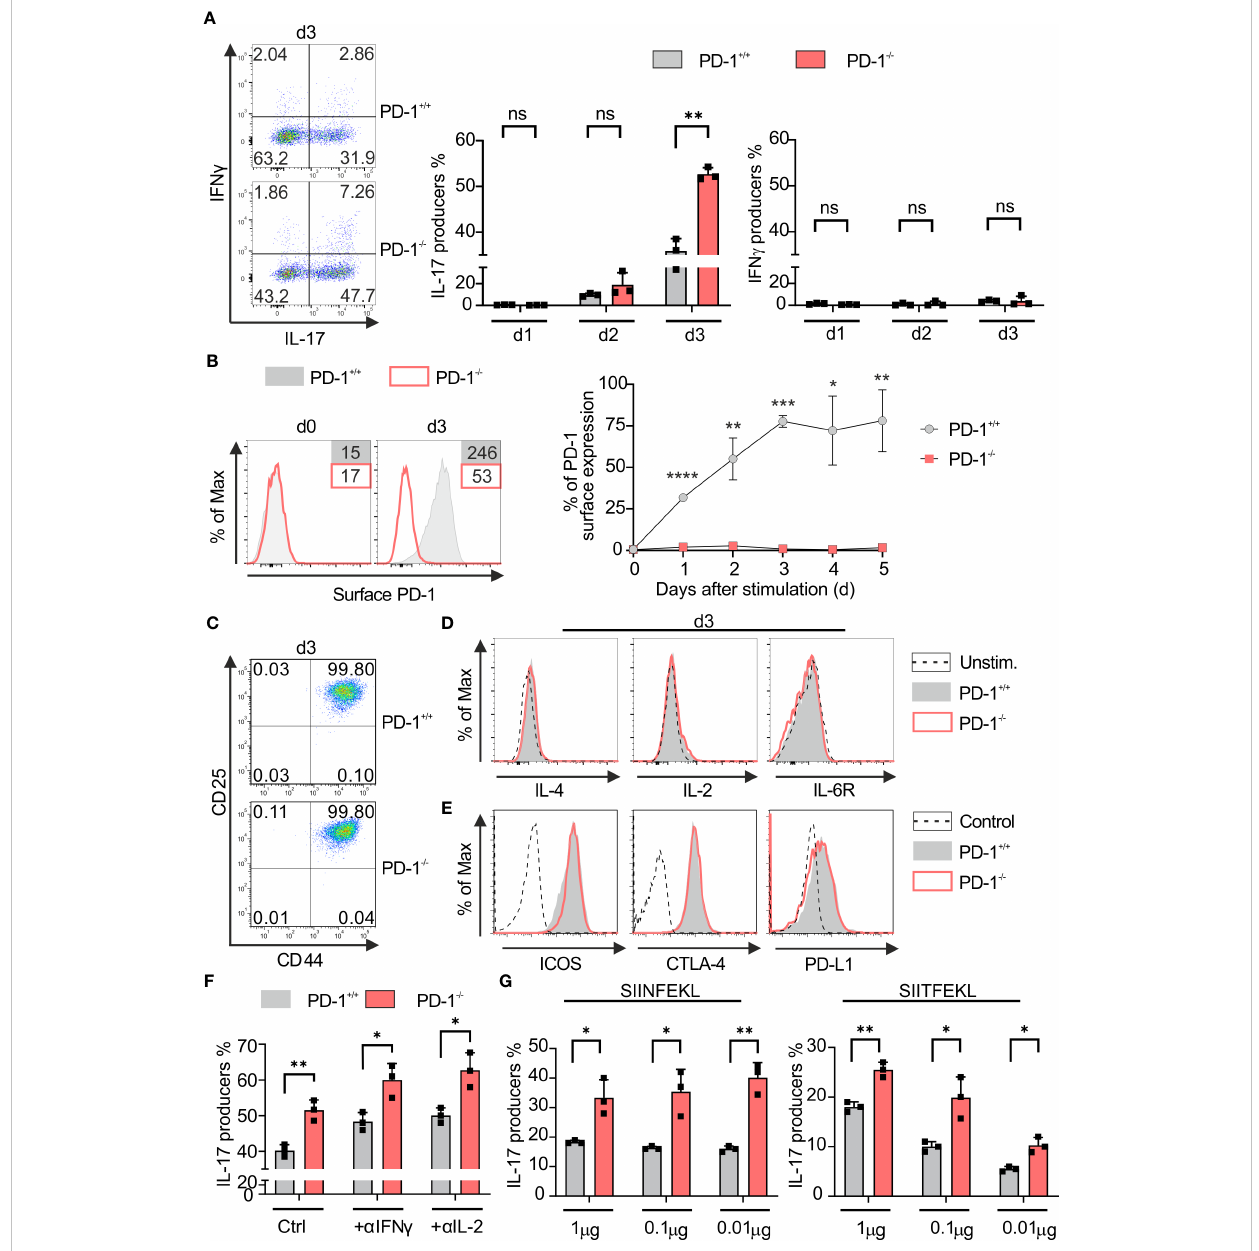
FIGURE 1 PD-1 restricts Tc17 differentiation. PD-1 +/+ and PD-1 -/- OT-1 naïve CD8 + T cells were activated antigen speci fi cally using OVA 257 – 264 loadedAPCs and cultured under Tc17 conditions. (A) Dot plot representing fl ow cytometric analysis of intracellular IL-17 and IFN- g expression (left panel) in OT-1 CD8 + T cells stimulated for 3 days under Tc17 conditions. Cumulative staining results from d1, d2 and d3 are shown on the right. (B) Histogram of PD-1 surface expression 3 days after antigen speci fi c stimulation of PD-1 +/+ Tc17 cells. PD-1 -/- Tc17 cells were used as negative controls. Graph representing kinetics of PD-1 expression on surface of PD-1 +/+ and PD-1 -/- Tc17 cells at different time points from day 0 to day 5. (C, D) Naïve PD-1 +/+ and PD-1 -/- OT-1 CD8 + T cells were stimulated as in (A) for 3 days and analyzed for the expression of activation markers CD25 and CD44 (C) , intracellular cytokines IL-4, IL-2, cytokine receptors IL-6R (D) by fl ow cytometry. (E) Histograms of surface expression of ICOS, CTLA-4 and PD- L1 in 3 day stimulated PD-1 +/+ and PD-1 -/- Tc17 cells. (F) Naïve PD-1 +/+ and PD-1 -/- OT-1 CD8 + T cells were stimulated as in (A) and intracellular